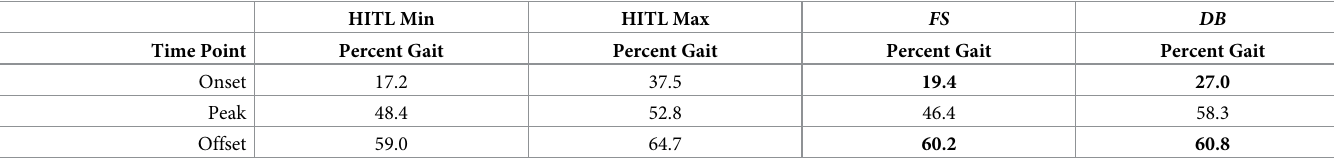
Table 1. HITL key point range for walking at 1.25 m/s as reported by Zhang et al. [8] and the corresponding points on the different approaches, for 1.4 m/s. Bold numbers fall withing the HITL range.